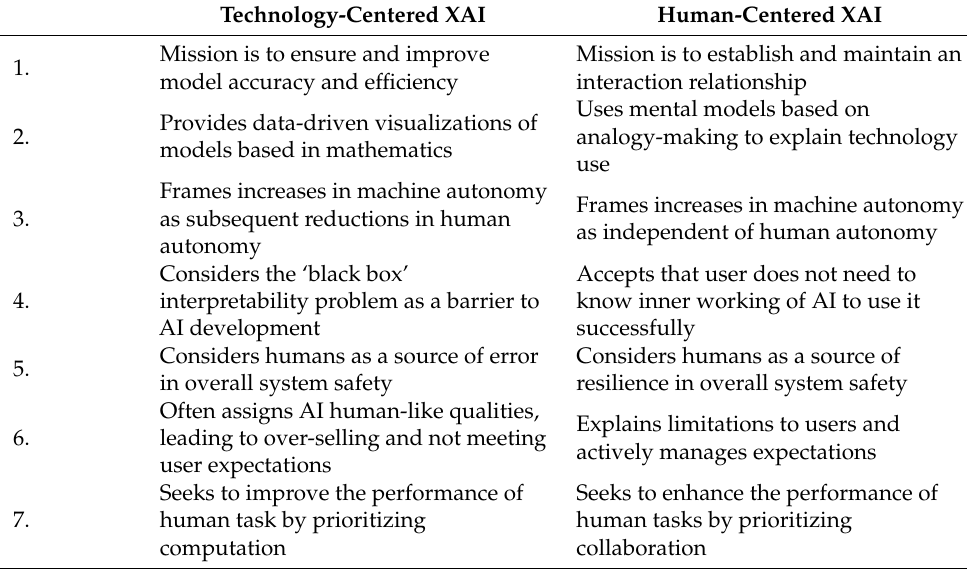
Table 2. Technology-centered XAI compared to human-centered